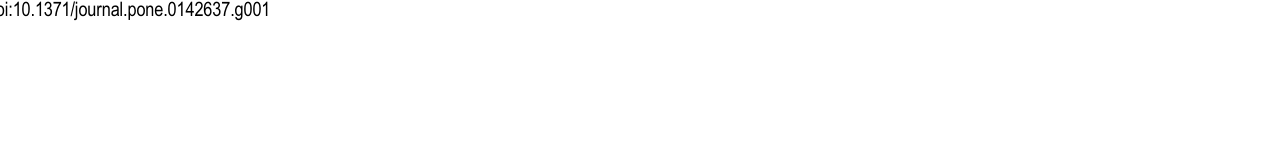
PLOS ONE | DOI:10.1371/journal.pone.0142637 November 12,